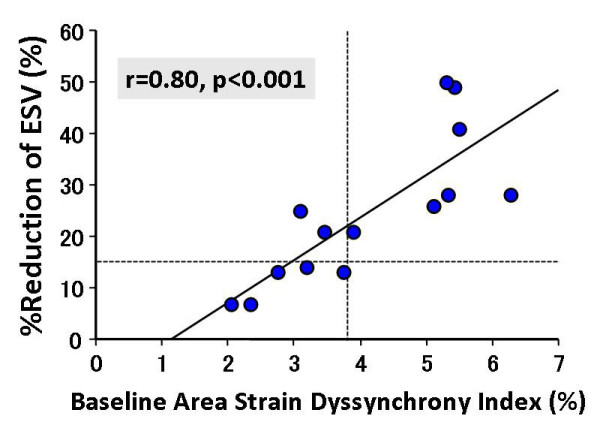
Dot plot of % reductions in end-systolic volume (ESV) in relation to area strain dyssynchrony index shows a significant correlation.